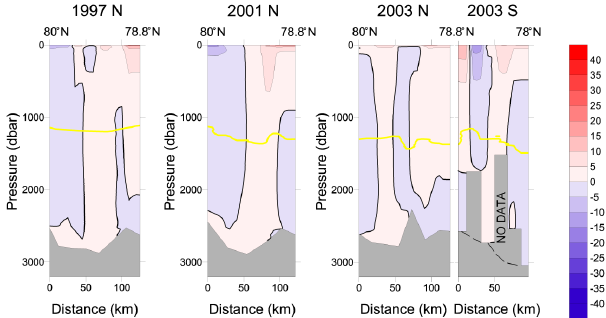
Fig. 5. Velocity with constraints applied from the meridional sec- Fig. 5 tions in 1997, 2001 and 2003 (Fig. 4) showing the constraint bound- ary, potential density ( σ θ ) surface 28.06 (yellow lines). Positive (negative) velocities are westward